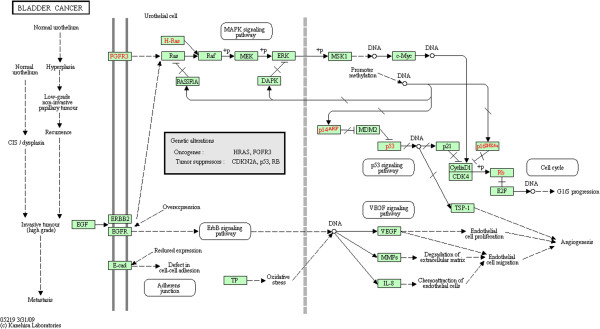
Pathway in bladder cancer, without PIK3R1.